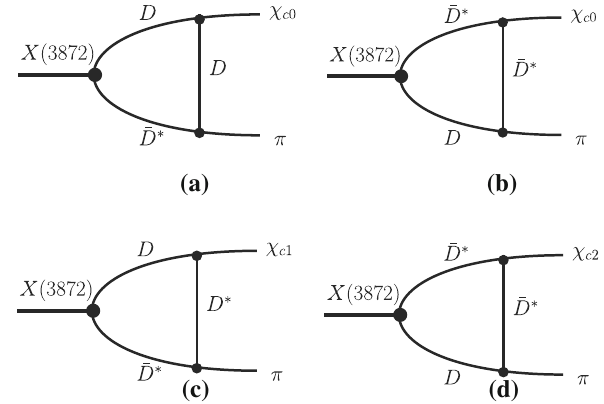
Fig. 2 Diagrams contributing to X ( 3872 ) → χ cJ π , the charge conju- gate diagrams are not shown but included in the